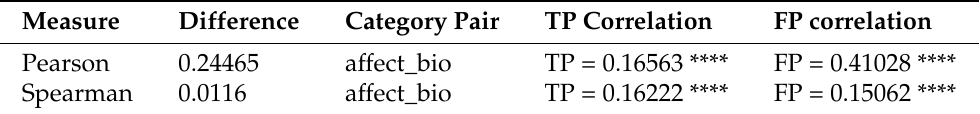
Table 27. Affect and Bio in Medium.